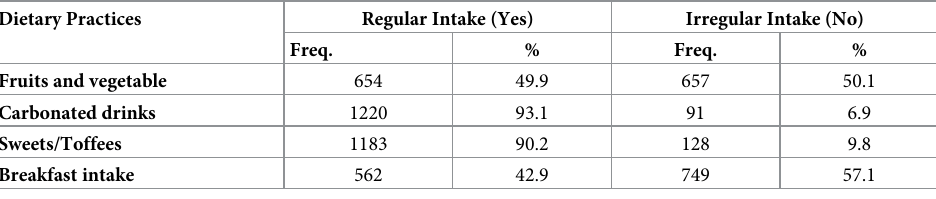
Table 1. Dietary practices of in-school